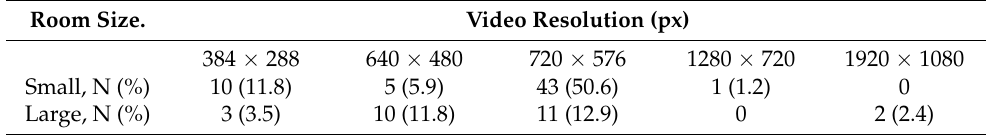
Table 2. Video resolution for the ASD sample. Room